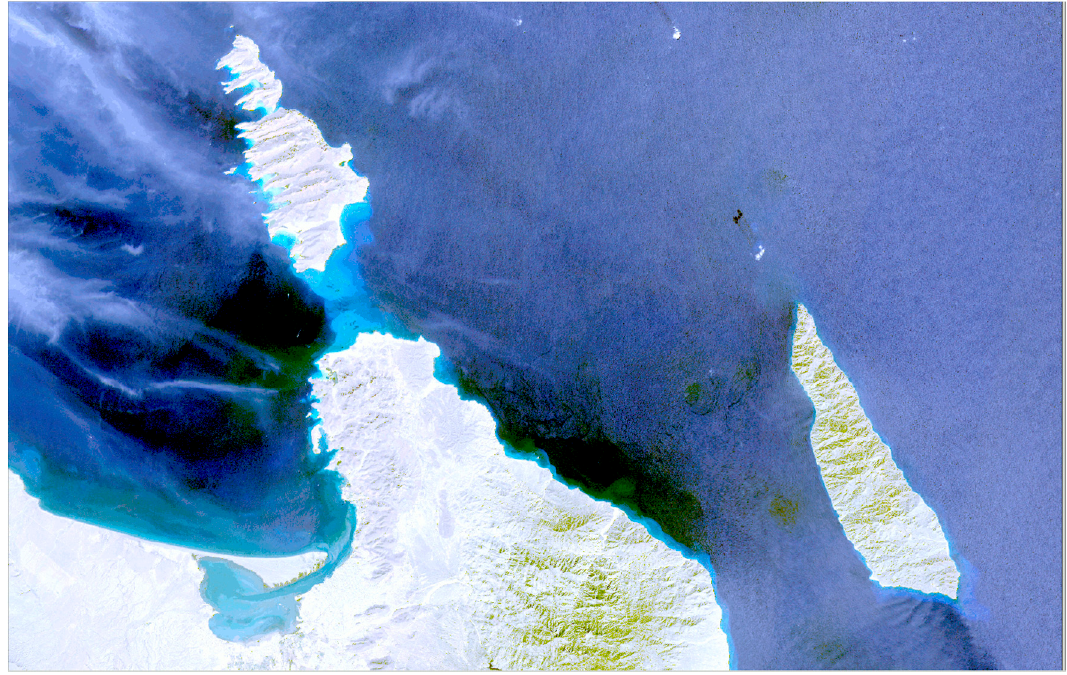
Figure A2. True color composite of the 27 October 2016 image. This scene exhibits a complex atmosphere and distinct blooms of discolored waters.